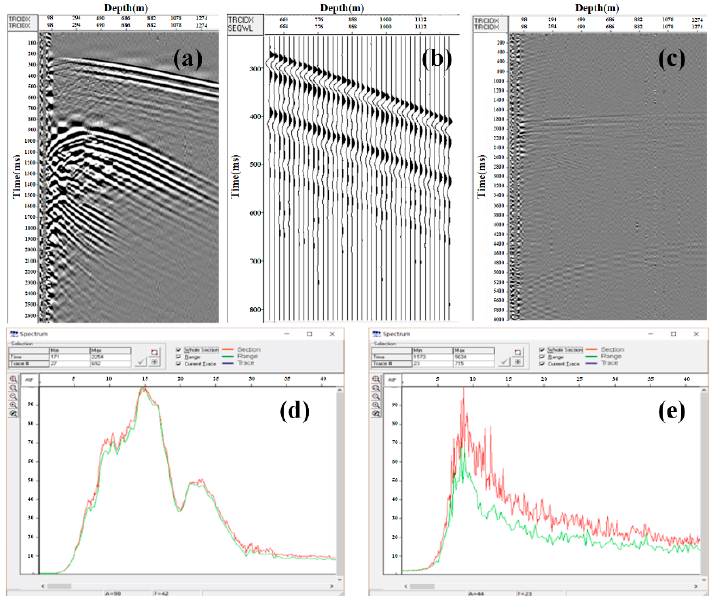
Figure 16. VSP test results for the microstructure fiber DAS system [75]: ( a ) “zero bias” test results; ( b ) schematic diagram of signal consistency; ( c ) “non ‐ zero bias” test results; ( d ) “zero bias” spectrum diagram; ( e ) “non ‐ zero bias” spectrum.